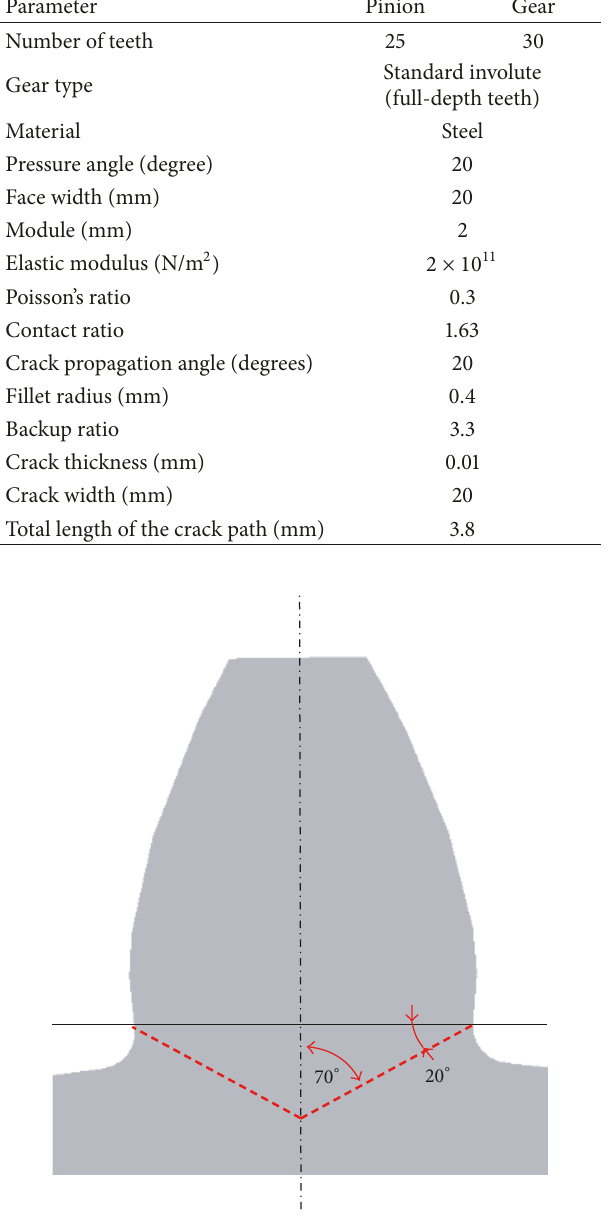
Figure 6: Crack propagation path [17].